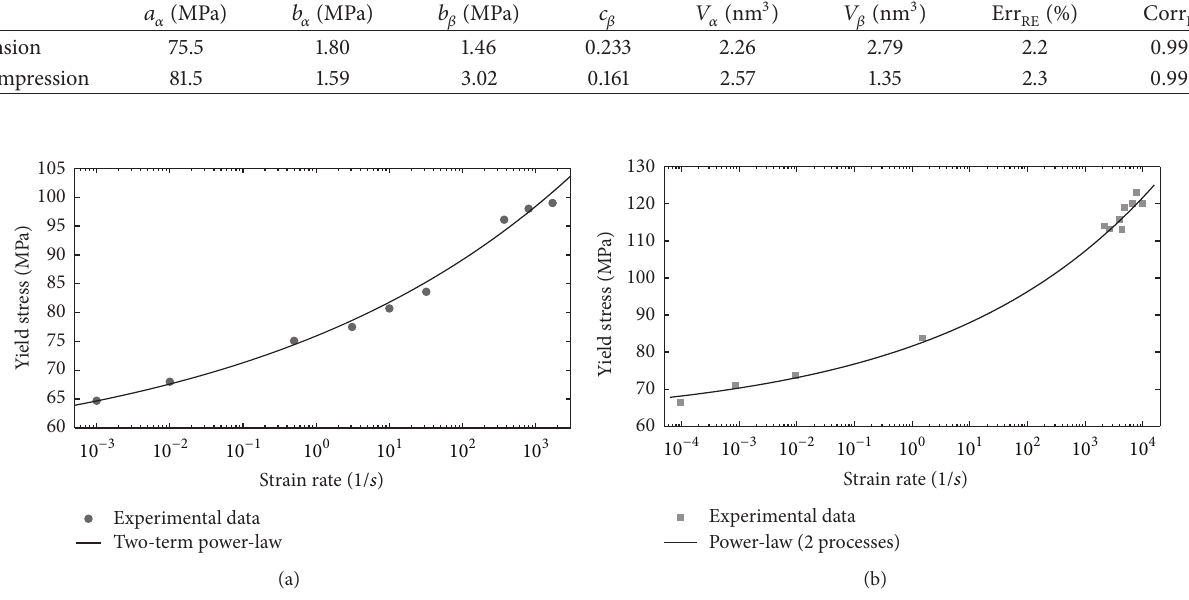
Figure 2: Experimental yield stress of PC fitted by the two-term power-law equation: (a) tension and (b)